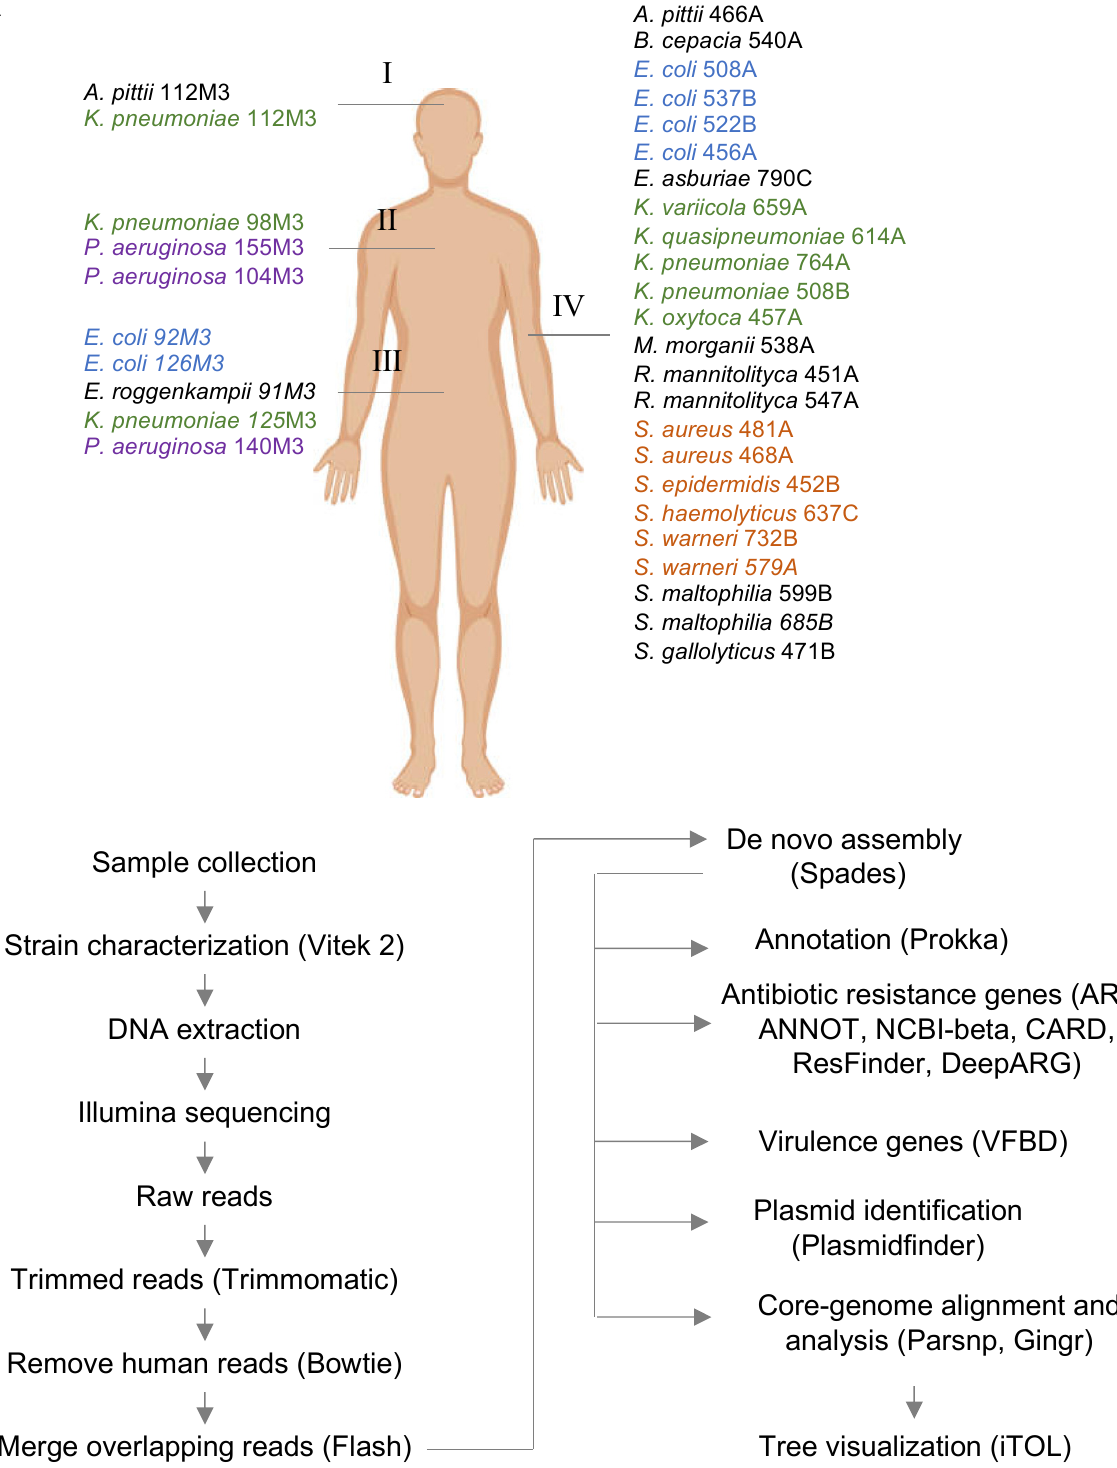
Figure 1. Overall strategy used for the whole-genome analysis of clinical strains. ( A ) In total, 34 bacterial strains were isolated from several samples, such as cerebrospinal fluid (I, 2 strains), bronchoalveolar lavage (II, 3 strains), ascitic fluid (III, 5 strains), and blood (IV, 25 strains). The four most common bacterial groups ( Klebsiella pneumoniae , Escherichia coli , Pseudomonas aeruginosa, and Staphylococcus spp.) are colored. ( B ) Schematic representation of the main bioinformatic pipeline used for genome sequencing, assembly, annotation, and identification of antibiotic resistance genes (ARGs) and virulence factor and genomic analysis.